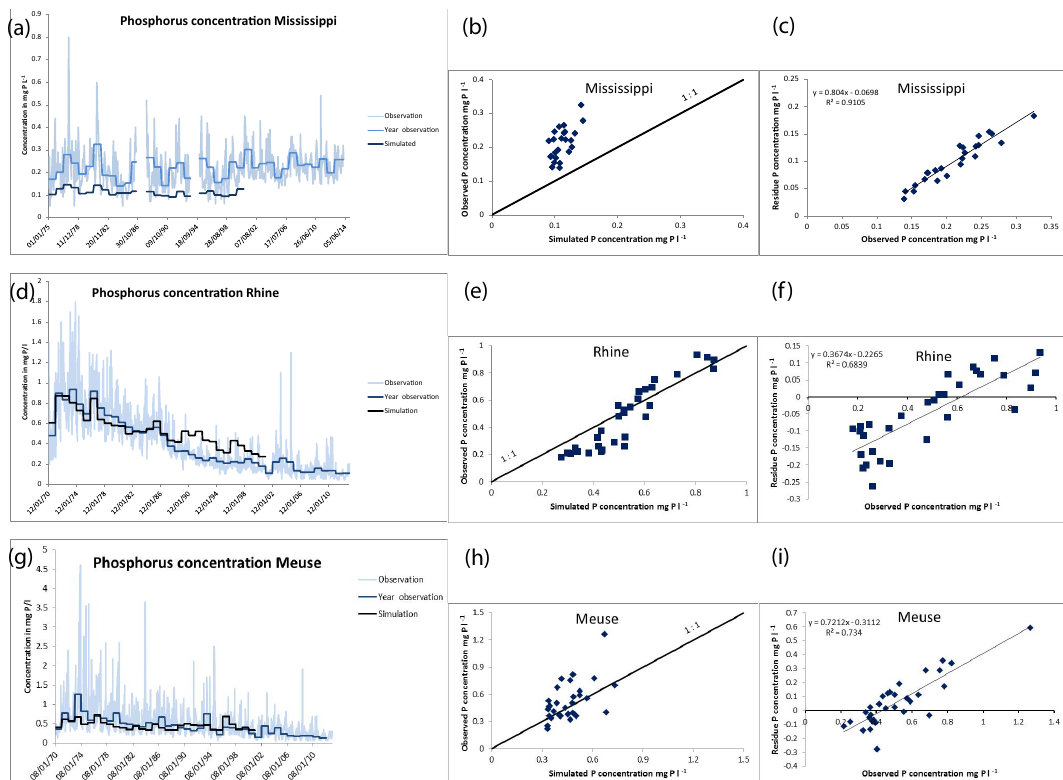
Figure 7. Comparison of modeled (black line) and measured (light blue, and aggregated yearly) discharge-weighed concentrations of total P in the rivers Mississippi (a–c) , Rhine (d–f) and Meuse (g–i) . Panels on the left are comparisons over time; panels in the center represent plots of simulations vs. observations with a 1:1 line, and panels on the right are the concentrations vs. the residues (observation minus simulation) with a regression